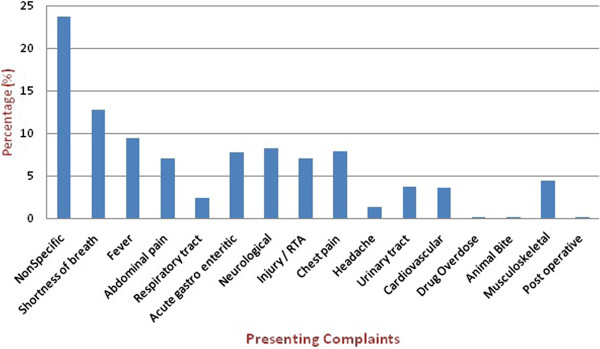
Presenting complaints of elderly patients.